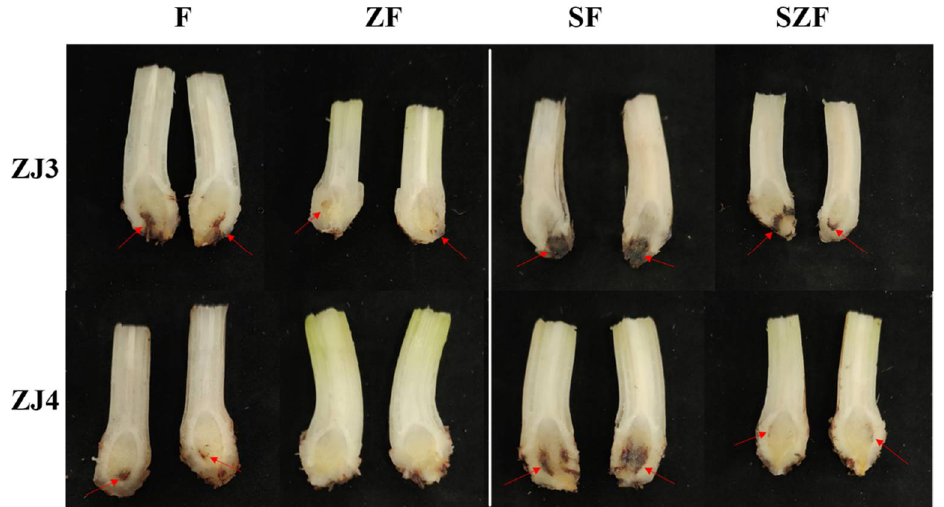
Figure 9. Symptoms in the corms of banana inoculated with Foc TR4. F, ZF, SF, and SZF represents Foc TR4 treated S. indica non-colonized control banana seedlings grown in nutrient soil, Foc TR4 treated S. indica colonized banana seedlings grown in nutrient soil, Foc TR4 treated S. indica non-colonized control banana seedlings grown in nutrient soil containing 1/4 bamboo fungus culture substrates, and Foc TR4 treated S. indica colonized banana seedlings grown in nutrient soil containing 1/4 bamboo fungus culture substrates, respectively. Red arrows represent browning areas in corms of banana.